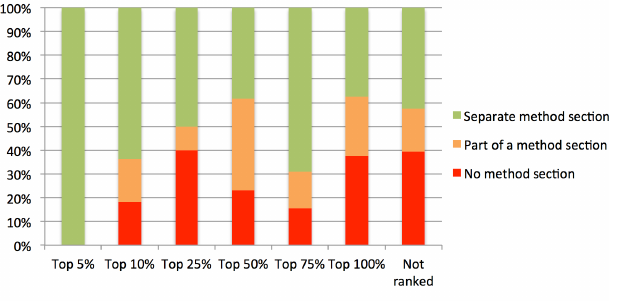
Fig. 8 . Methodological transparency across journal ranking